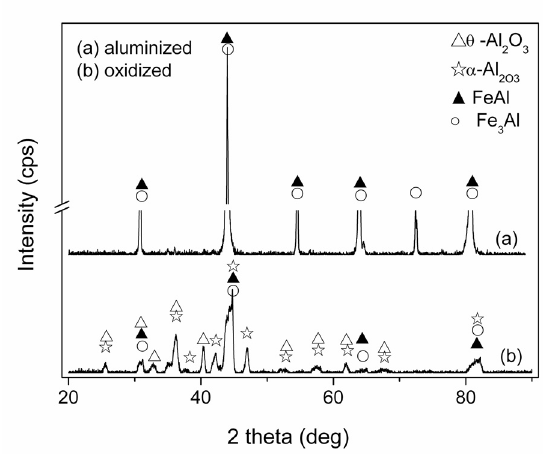
Figure 2. X-ray profiles of the specimen. (a) After pack cementation (b) after oxidation in H 2 C 2:23 vol. % water vapor at 1273 K for 20